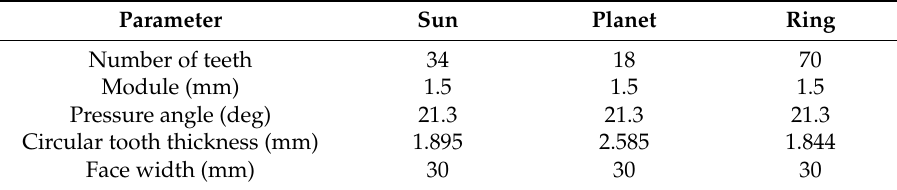
Table 1. Parameters of the planetary gear drive